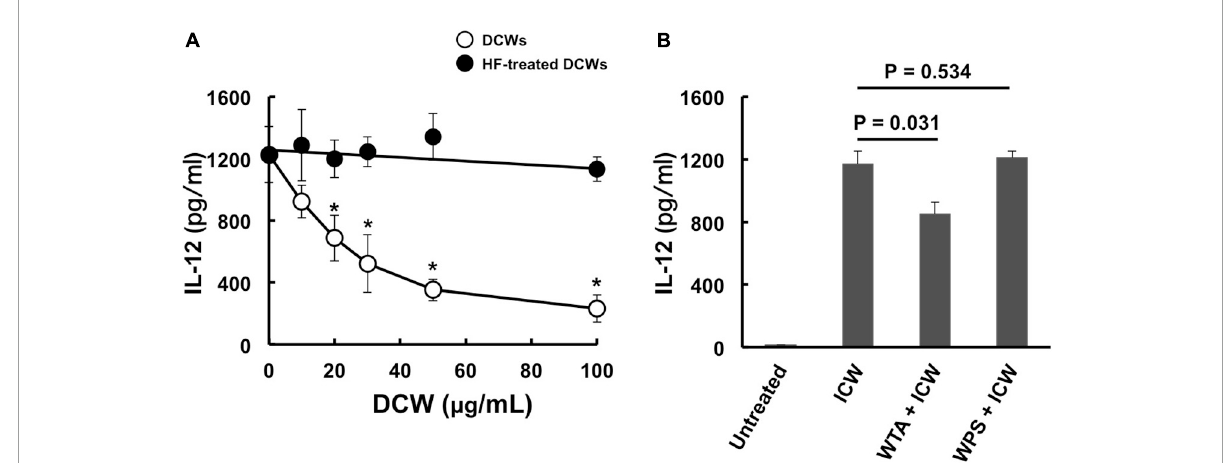
FIGURE10 Inhibition of immunomodulation by ICWs by pretreatment of cells with DCWs and soluble WTAs. (A) J774.1 cells were treated with various concentrations of DCWs of L. plantarum TUA 5099L (open circles) or HF-treated DCWs (closed circles) for 30 min at 37 ◦ C with gentle rotation. Then the cells were cultured with 10 µ g/ml of ICWs of L. plantarum TUA 5099L for 24 h, and IL-12 secreted in culture supernatants was determined. Each bar is the mean ± SE for three independent experiments. * P < 0.01 vs. DCW-untreated cells. (B) Cells were treated with 500 µ g/ml of purified soluble WTAs or WPS of L. plantarum TUA 5099L for 30 min at 37 ◦ C. Then the cells were stimulated with 10 µ g/ml of ICWs of L. plantarum TUA 5099L for 24 h, and IL-12 secreted in culture supernatants was determined. Each bar is the mean ± SE for three independent